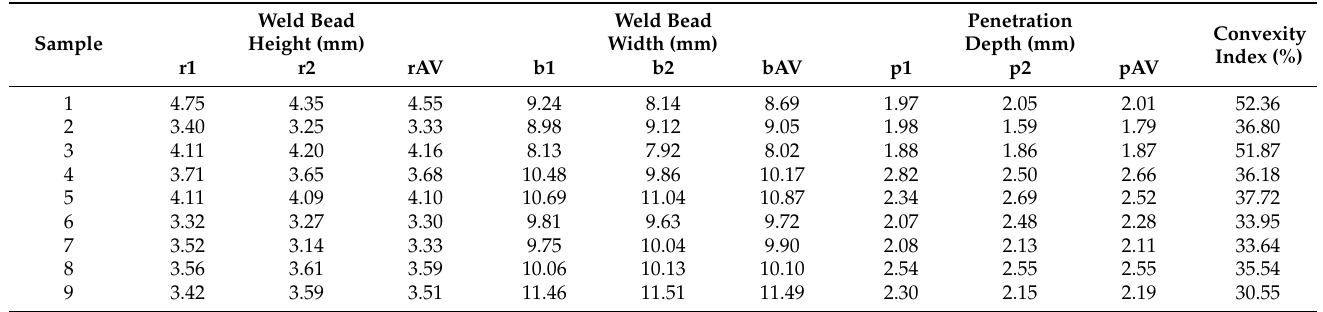
Table 3. Experimental layout (L9) orthogonal array and measured welding geometry.